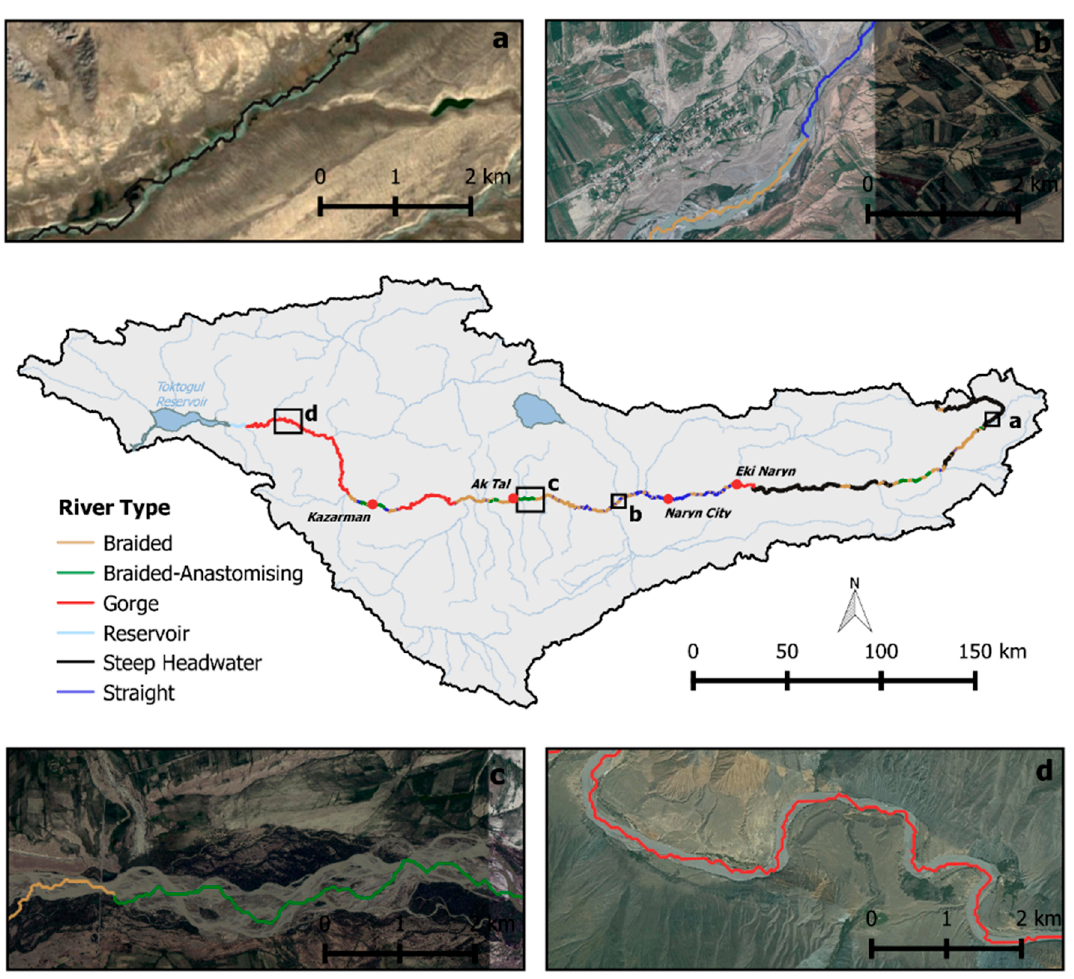
Figure 8. Results of the planform mapping based on virtual globe imagery; the insets ( a – d ) show detailed examples of the most relevant river types.